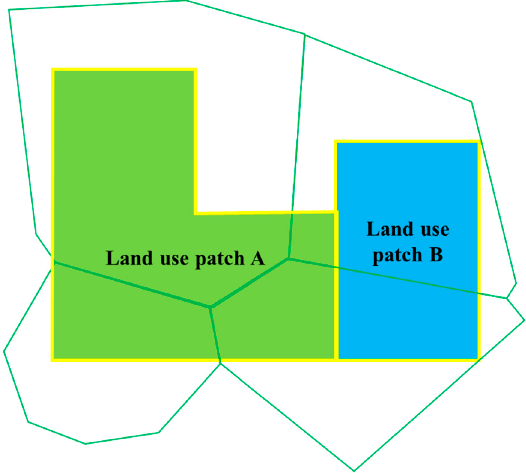
Figure 17. Quantitative indices for divided fragmentation of land use patches.